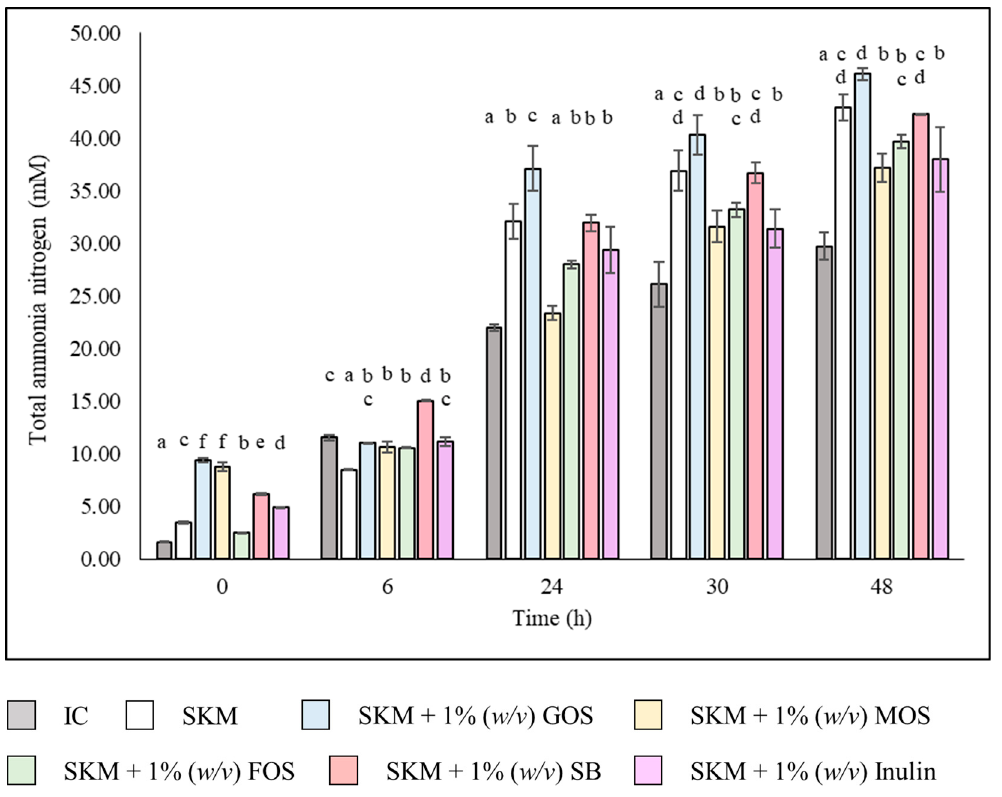
Figure 3. Concentration (mM, means ± SD) of total ammonia nitrogen produced during 48 h of fecal fermentation. Different letters mark statistically significant ( p < 0.05) differences between each condition at same sampling time. IC—inoculum control; SKM—skim milk; GOS—galacto- oligosaccharide; MOS—mannan-oligosaccharides; FOS—fructo-oligosaccharides; SB— S. boulardii .